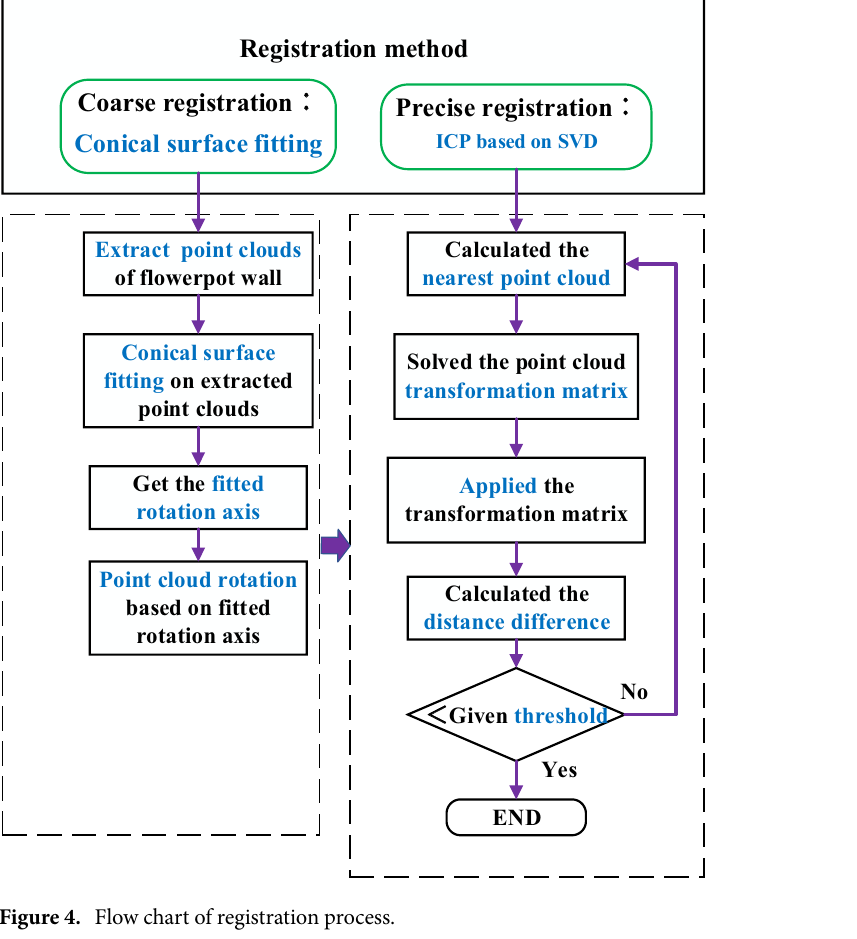
Figure 4. Flow chart of registration